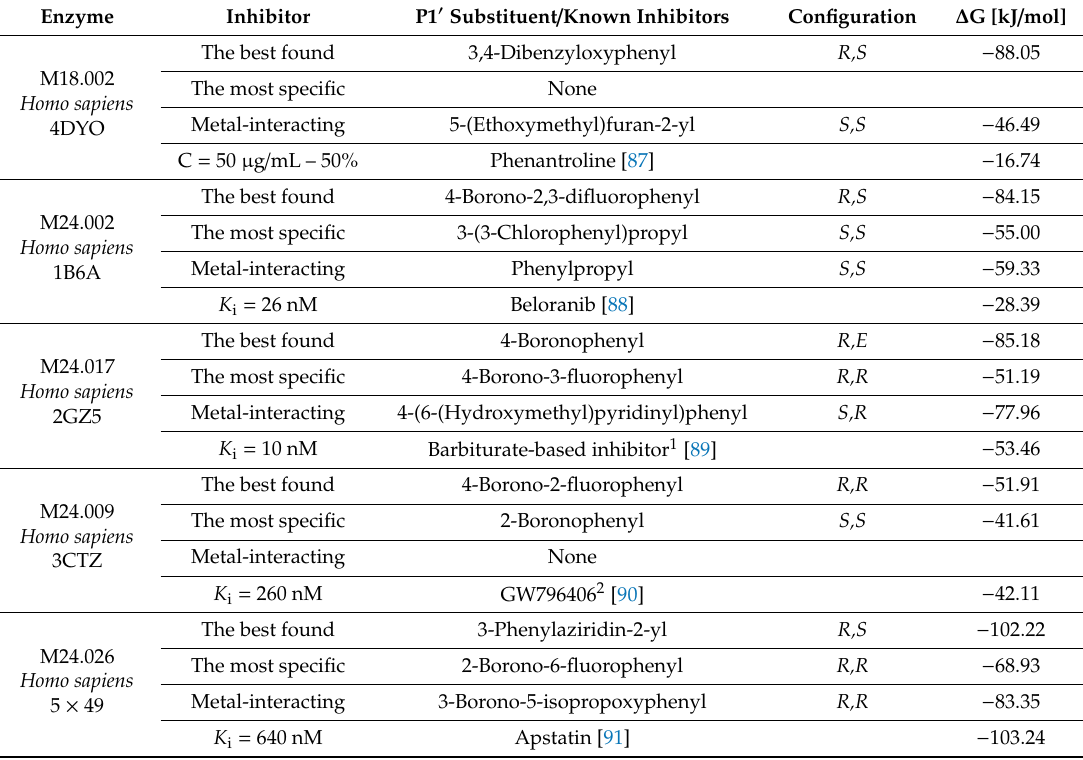
Table 5. Selected human metallo-aminopeptidases with P1 (cid:48) substituents that were the most favored, had the best interaction with the catalytic metal ion via the phosphinate group, and were the most specific are shown. The stereochemistry of the ligands and the calculated Gibbs free energy of binding in the active center are included. Known inhibitors are given as references.